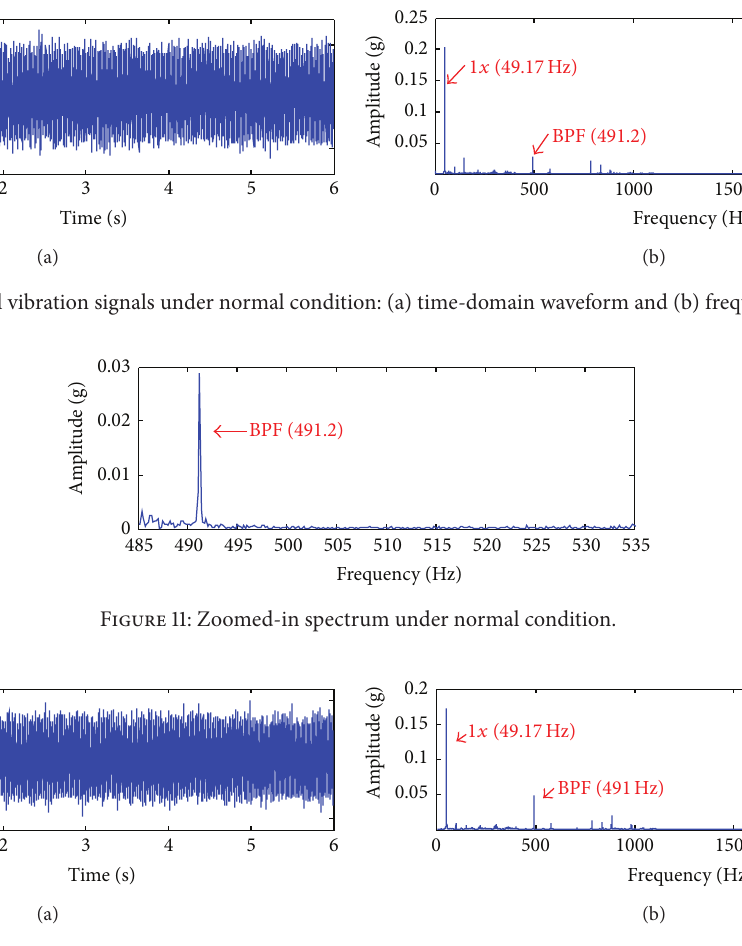
Figure 12: Original vibration signals under 16mm crack condition: (a) time-domain waveform and (b) frequency